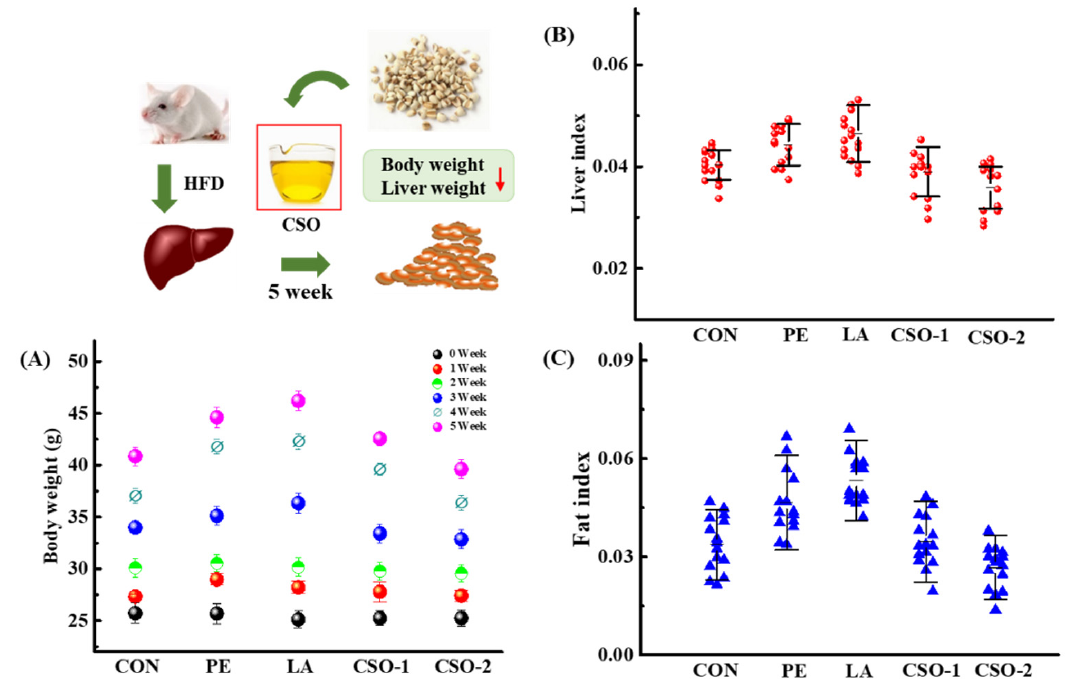
Figure 1. Effects of PE, LA and CSO therapy on the phenotype (body weight, liver, and fat index) in the HFD mice. A total of 75 HFD mice were randomly divided into control group (CON), PE, LA and CSO groups, and these mice from all groups were fed for 5 weeks. ( A ) Body weight alterations of mice during 5 weeks; ( B ) Liver index alterations from five groups; ( C ) Fat index alterations from five groups (CON: given normal saline group; PE: given peanut oil group; LA: given lard group; CSO-1 and CSO-2: CSO oral injection groups of 30 mg/kg/BW and 50 mg/kg/BW, respectively).